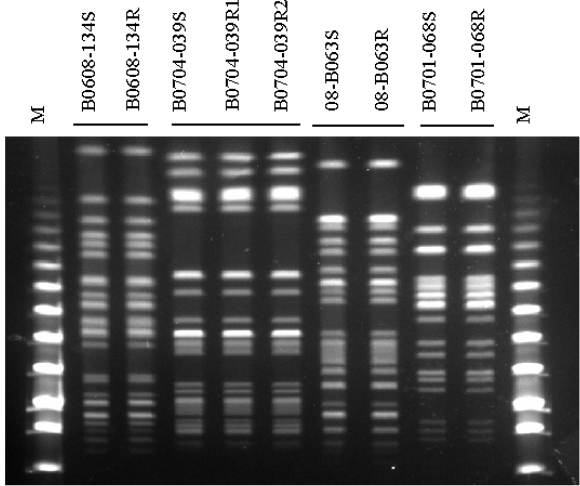
Figure 1. Pulsed-field gel electrophoresis (PFGE) profiles obtained with restriction enzyme XbaI.